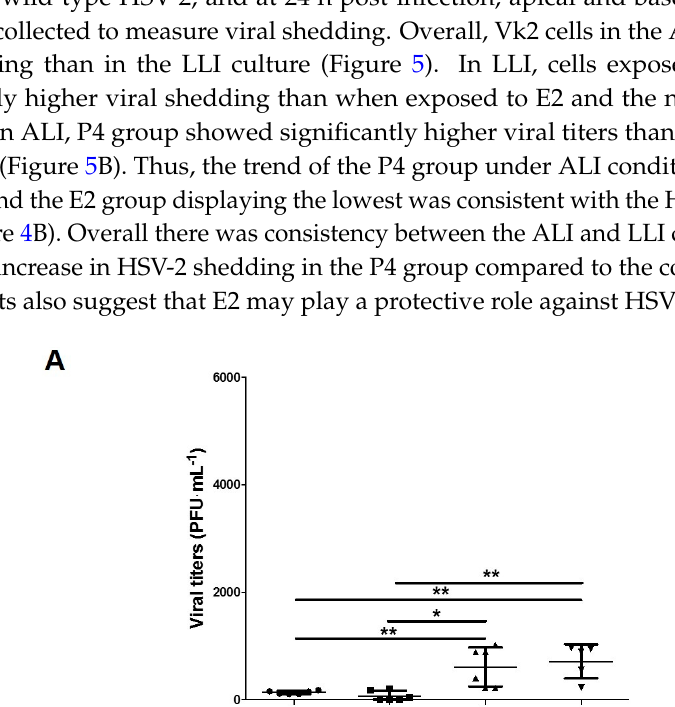
Figure 5. Difference in HSV ‐ 2 virus shedding by Vk2 cells in ALI and LLI conditions, exposed to different female sex hormones and MPA. To measure the viral shedding in Vk2 cell supernatants, Vk2 cells were exposed to 10 4 PFU of wild ‐ type HSV ‐ 2 for 2 h in both LLI ( A ) and ALI ( B ). Apical